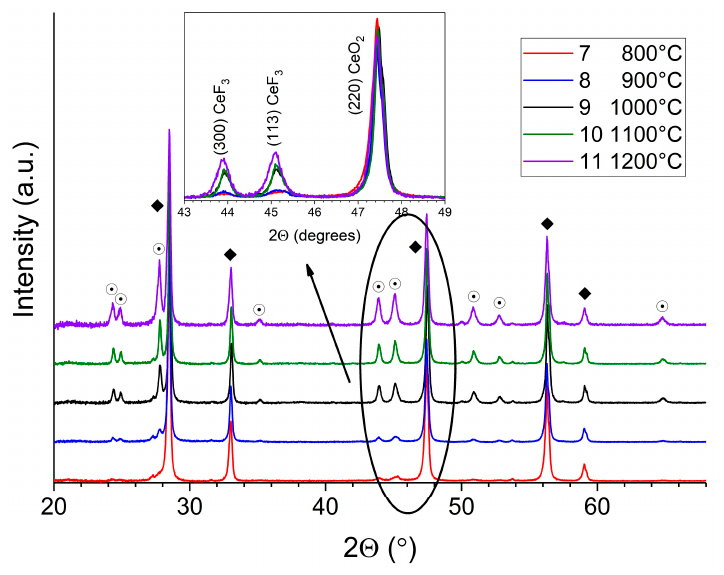
Figure 3. XRD patterns of samples 7–11. The insert shows the change in intensities of XRD lines (300) and (113) assigned to the CeF 3 crystalline phase for temperatures 800 °C–1200 °C. Table 2. The calculated lattice parameters (Å) for crystalline phases found from XRD